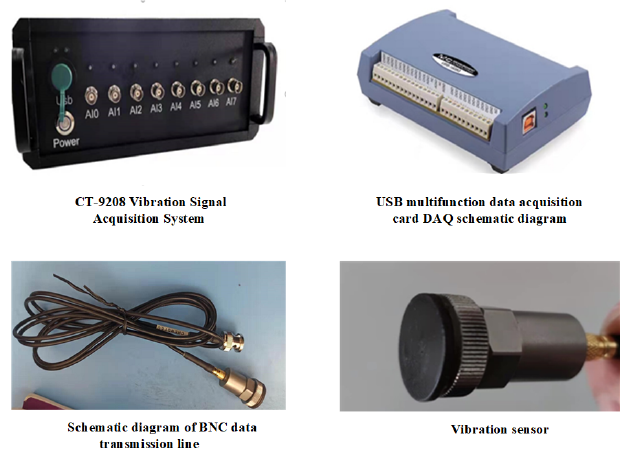
Figure 7. Data Collection